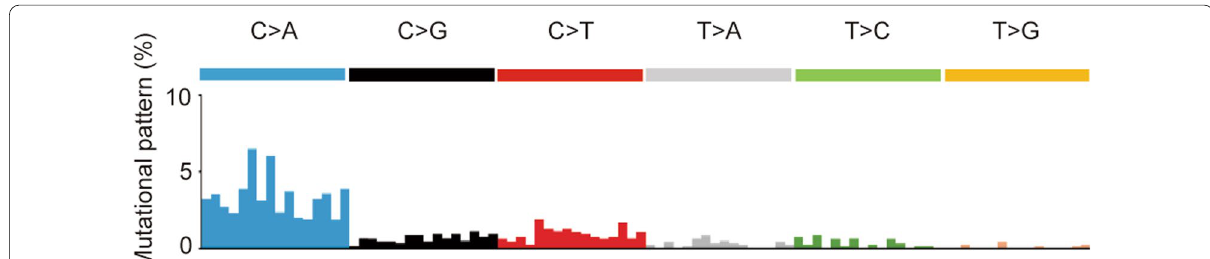
Fig. 3 COSMIC mutational signature of the gastric tumor. The signature showed signature 4 (version 2 in COSMIC [https:// cancer. sanger. ac. uk/ cosmic/ signa tures_ v2]), which was associated with smoking and which has been found in lung cancer, head and neck cancer, and liver cancer. The order of mutation patterns conforms to COSMIC